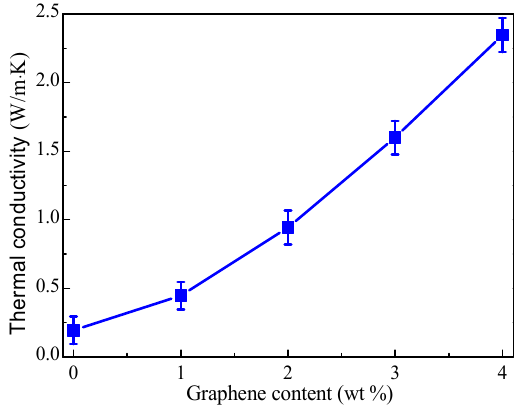
Figure 3. Effect of graphene content on the thermal conductivity of the polymer composite coatings.